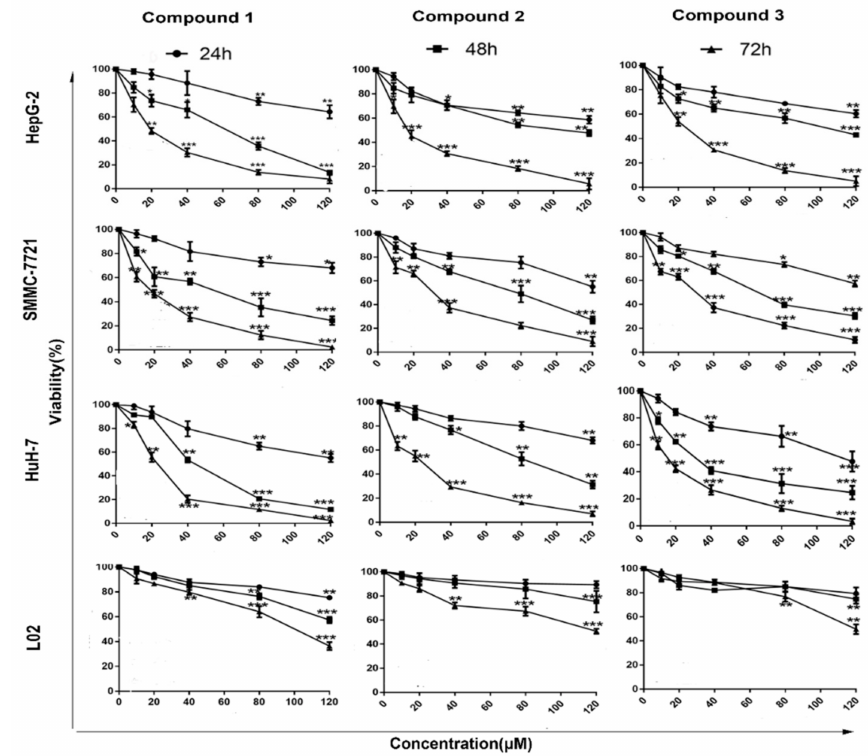
Figure 1. The viability of HCC cells and L02 cells treated with compounds 1 , 2 , and 3 . The viability of HCC cells and L02 cells treated by compounds 1 , 2 , and 3 (0, 20, 40, 60, 80 and 120 µ M). Cell viability values are expressed as mean ± SD ( n = 3). Significant differences from the control are indicated by * p < 0.05, ** p < 0.01, *** p <